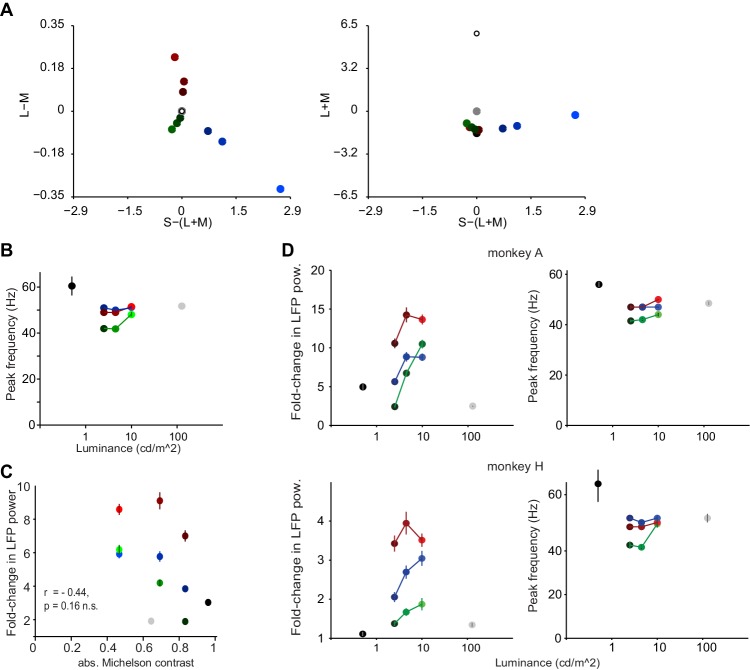
Dependence of gamma LFP power on the surface hue: further analyses in relation to main Figure 4B.(A) Representation of hues used for Figure 4B in DKL space. (B) Peak frequency estimates (Hz) based on cross-validated fitting procedure (see Materials and methods) for the surface stimuli of Figure 4B. (C) A regression of absolute luminance contrast (Michelson contrast) against gamma peak height (fold-change) showed no significant relationship (p=0.23). Note that since there was relatively little gamma power for achromatic, high-contrast stimuli, if anything there would be a negative relationship between luminance contrast and gamma power, the very opposite of findings about gamma power for achromatic gratings. Also note that for red stimuli, gamma power appears to follow a U-shape with decreasing luminance and increasing contrast (see also Figure 4A). (D) Gamma power (fold change) and peak frequency estimates (Hz) for the surface stimuli of Figure 4B, per animal. For both animals, the brightest stimuli showed stronger gamma-responses than the darkest stimuli. The difference in fold-change gamma amplitude as a function of luminance was greater for green than for red for both animals and significantly greater than blue in monkey A. Moreover, red responses across luminances were stronger than green or blue responses, with the exception of the brightest blue responses in monkey H. (B-D) Color hues were adjusted for better discriminability given the small dot sizes, (A) shows actual hues.